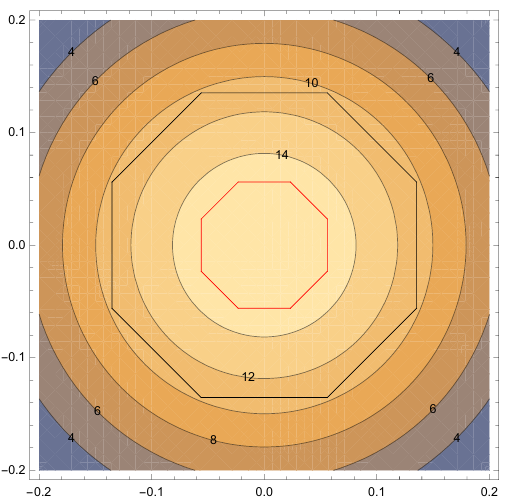
Figure 6. Contour plot of the intensity of peaks as a function of the perpendicular space coordinates. The black octagon delimits the region corresponding to all sites of the p = 1 OT, and the red octagon delimits the region corresponding to z ≥ 5